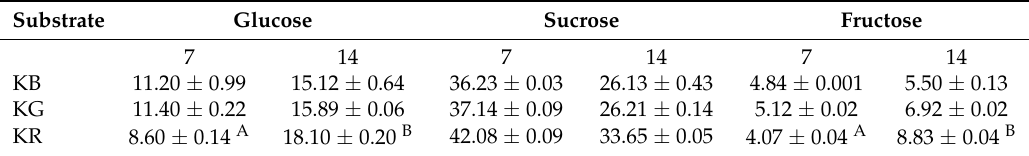
Table 3. Concentration (mg/mL) of glucose, sucrose, and fructose in Kombucha prepared with black tea (KR), green tea (KG), and rooibos tea (KR) at 7 and 14 day of fermentation.